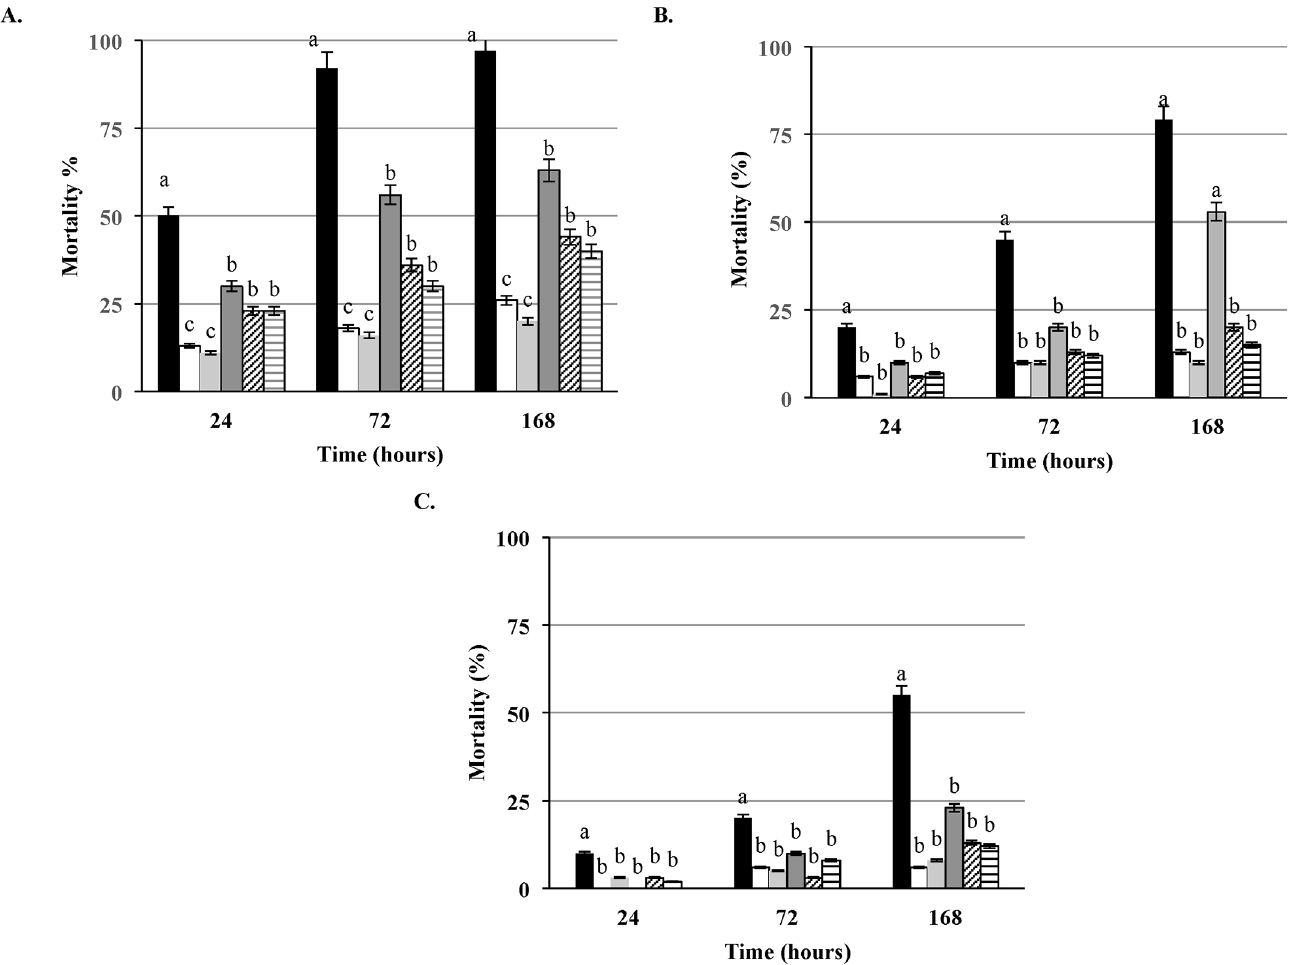
Fig 2. Comparison of virulence of L . monocytogenes isogenic mutants in G . mellonella . Comparisonbetweenwild type L . monocytogenes strain LS1209(designated with black square) and isogenicmutants with deletionin prfA LS496 (designated with white square) hly LS1212 (designated with light gray square), plcA LS1210(designated with dark gray square), plcB LS1211(designatedwith dark upwarddiagonalsquare) and actA LS1213(designatedwith dark narrowhorizontalsquare) in larvae infected at the doses of at the doses of (A) 10 6 CFU/larva (B) 10 5 CFU/larva, (C) 10 4 CFU/larva > b > c (P < 0.05). Presentedresults are averageof three independent trials.